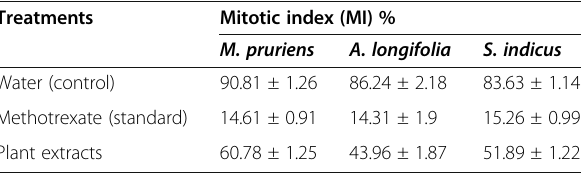
Table 3 Percentage cell viability of MCF7 and A549 cell line after treatment with M. pruriens , A. longifolia and S.